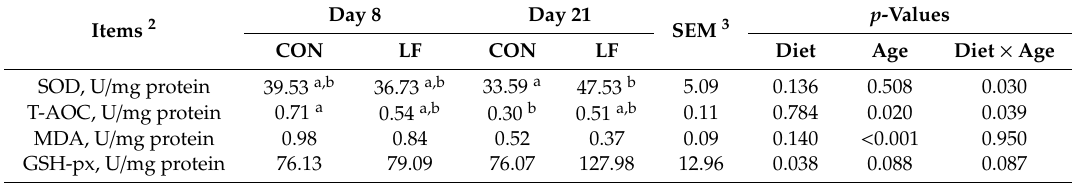
Table 5. E ff ects of lactoferrin on duodenal antioxidant parameters of suckling piglets 1